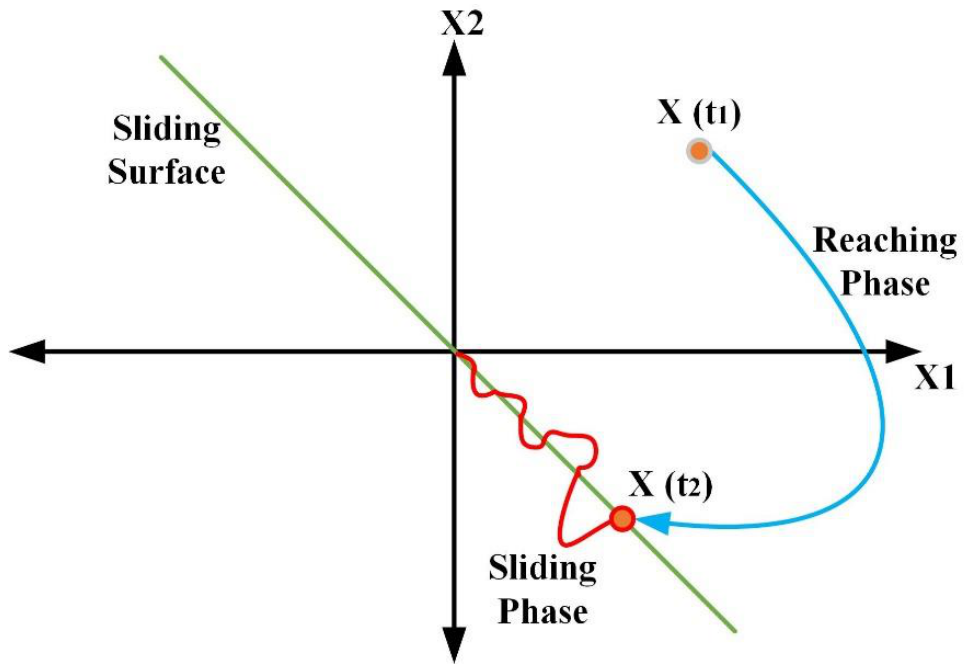
Figure 3. Graphical representation of SMC [42].